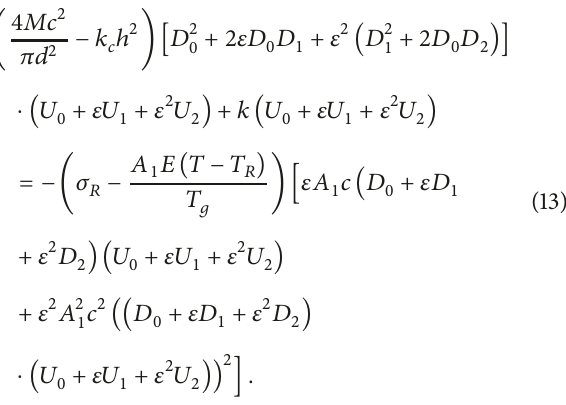
a function of temperature presented in Figure 11, where the parameter 𝜀 ∈ [0.02, 0.03] . Larger value of ApEn for